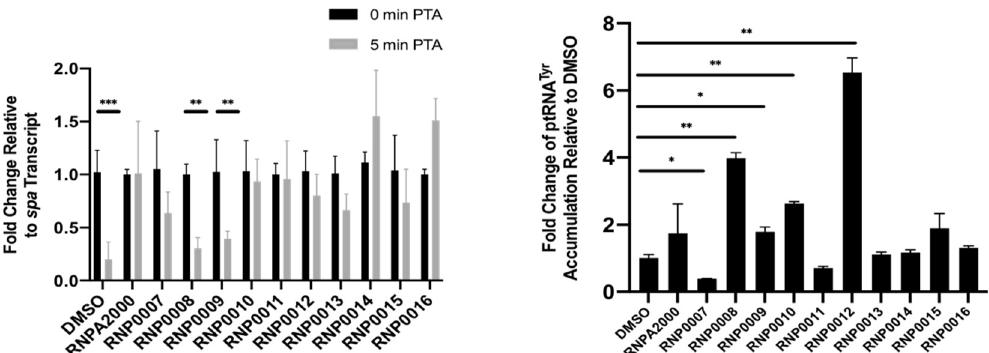
Figure 3. Quantitative RT-PCR measures of spa transcript turnover (left) and ptRNA Tyr accumulation (right) in S.aureus UAMS-1 cells treated with DMSO, JR analogs or RNPA2000 (positive control). For spa RNA turnover measures, cells were treated with 0.5X MIC of each compound for 30 min prior to transcriptional arrest. For ptRNA Tyr accumulation studies, cells were treated 0.5X for 1 h. Each compound was evaluated twice, and values averaged. * p -value < 0.05, ** p -value < 0.01, *** p -value < 0.0001 (Two-way ANOVA).